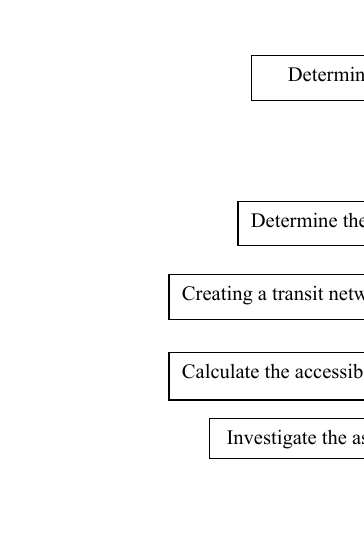
Figure 1 . Research